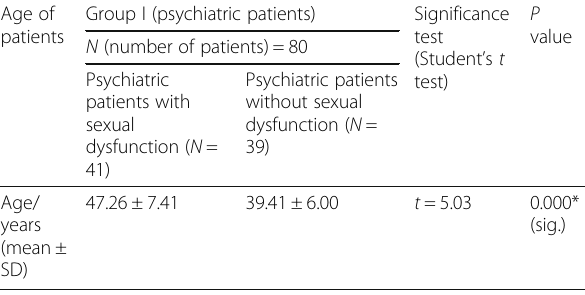
Table 11 Correlation between age of patients and clinical scales (IIEF and SBQ) among patients of group I (psychiatric patients)